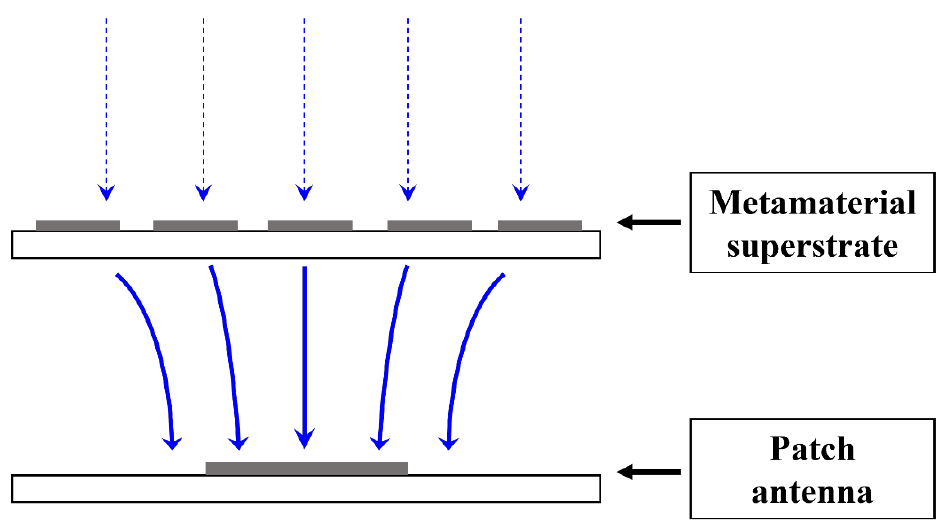
Figure 1. Principle of a gain improvement property of the MTM superstrate.